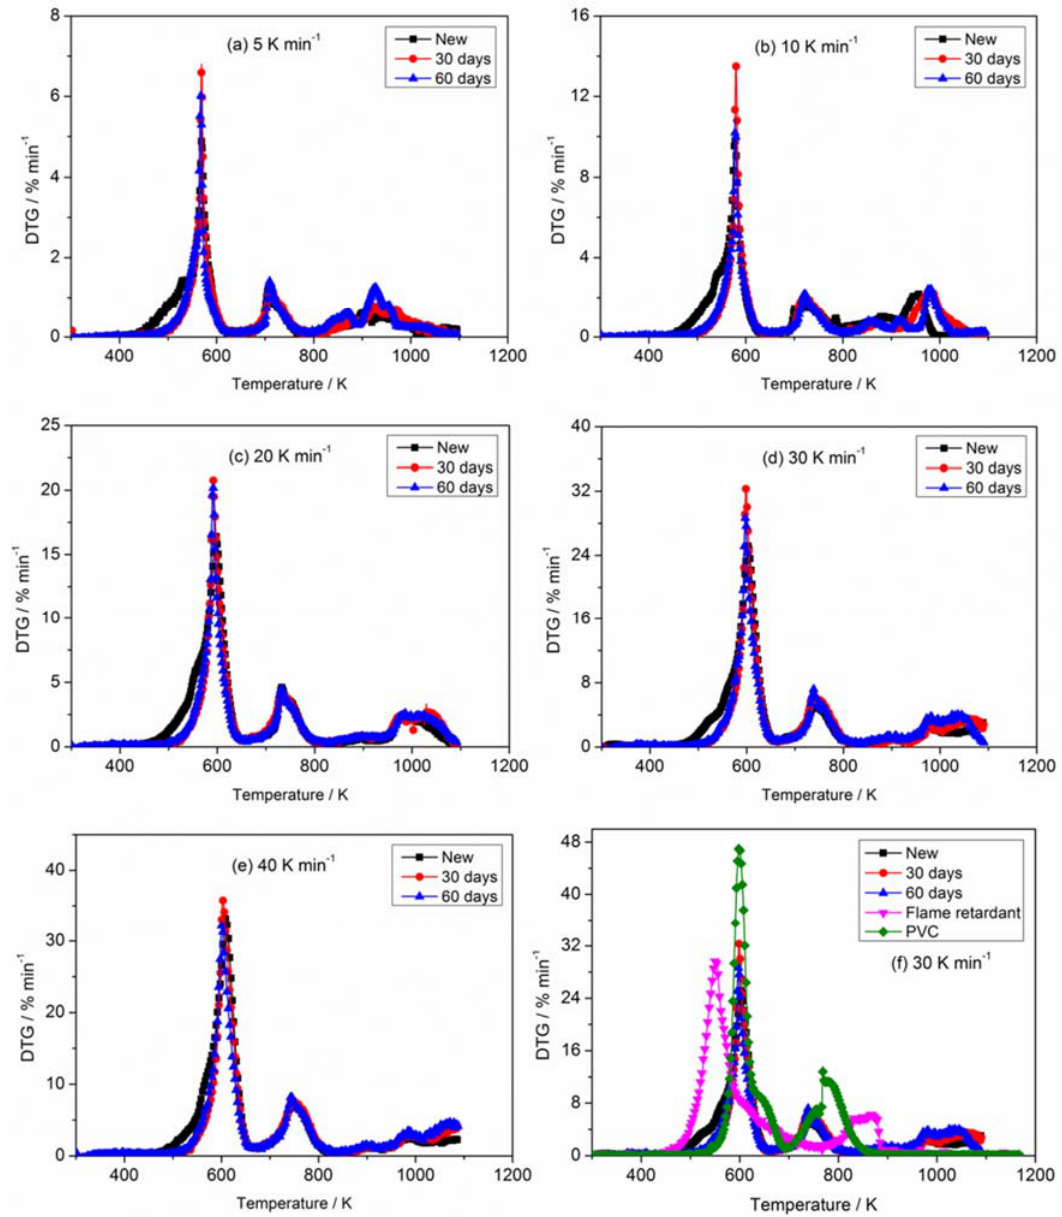
Figure 5. Comparison of DTG of PVC sheaths for new and aged cables at different heating rates in nitrogen atmosphere. ( a ) 5 K min − 1 ; ( b ) 10 K min − 1 ; ( c ) 20 K min − 1 ; ( d ) 30 K min − 1 ; ( e ) 40 K min − 1 and ( f ) 30 K min − 1 involving raw materials.